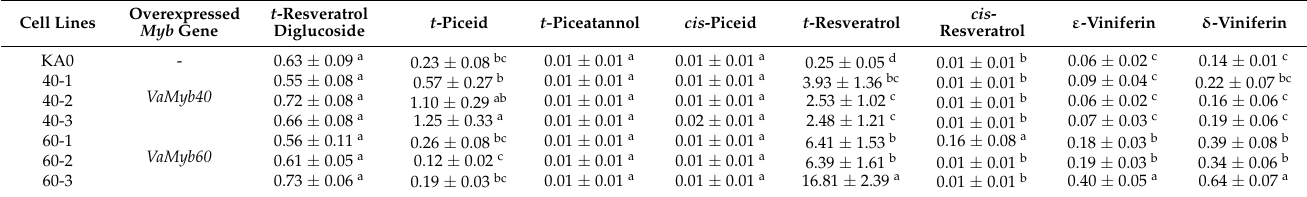
Table 2. The content of individual stilbenes (mg per g of the dry weight (DW)) in the transgenic cell lines of Vitis amurensis transformed with VaMyb40 or VaMyb60